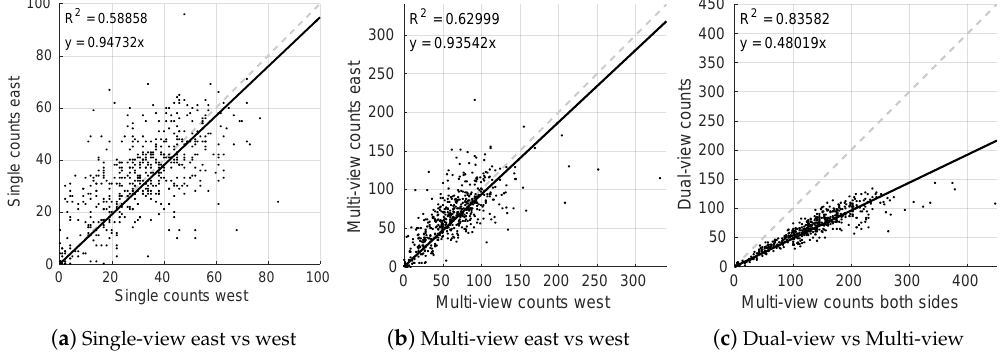
Figure 10. Linear models for the estimated number of fruits per tree compared to the harvest fruit count for: ( a ) single views of each tree (from the east); ( b ) dual opposing views; and ( c ) the proposed multi-view method. The line of equality is marked in grey.